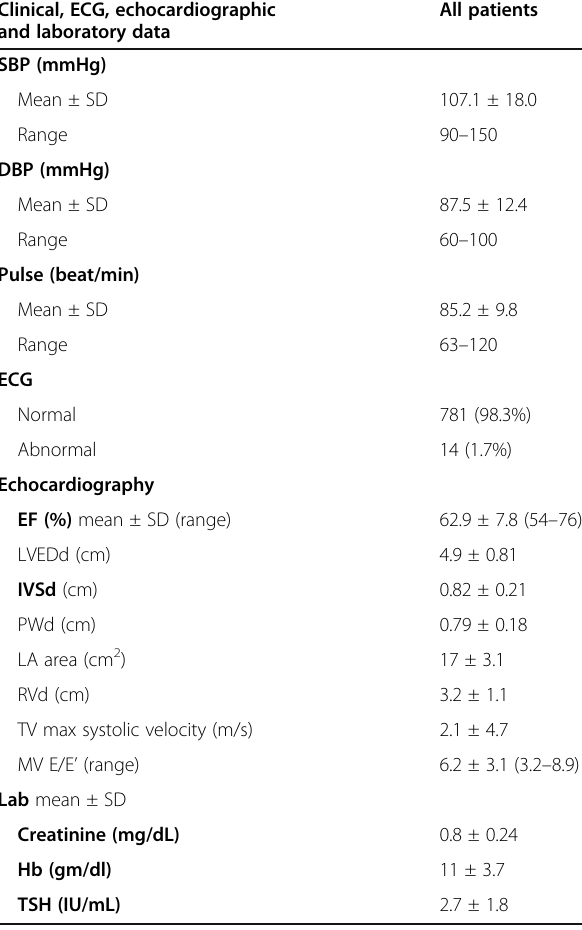
Table 4 Baseline clinical, ECG, echocardiographic, and laboratory data Clinical, ECG, echocardiographic and laboratory data